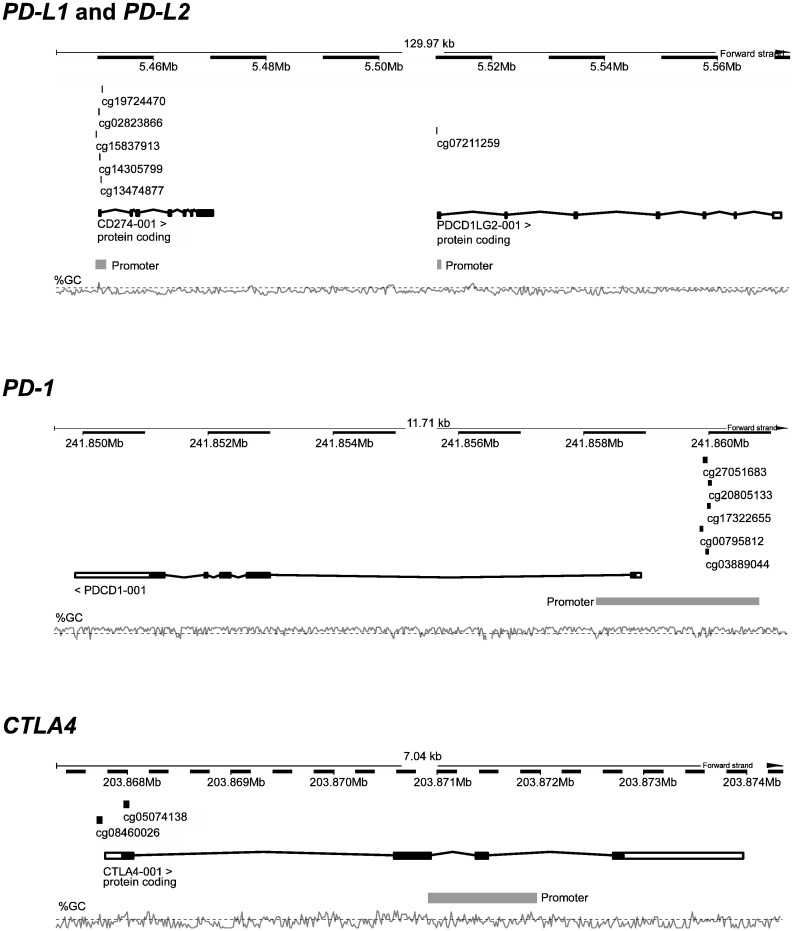
Genomic location and organization of CD274 (PD-L1) and PDCD1LG2 (PD-L2) on chromosome 9, PDCD1 (PD-1) on chromosome 2, and CTLA4 on chromosome 2. Analyzed cg-beads from the Illumina Infinium HumanMethylation450 BeadChip are illustrated. Figure information is based on the Genome Reference Consortium Human Build 38 patch release 7 (GRCh38.p7) illustrated by http://www.ensembl.org.